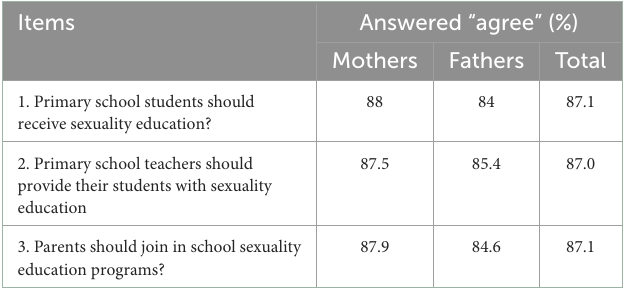
TABLE 3 Parental attitudes toward sexuality education of children ( N = 19,745).